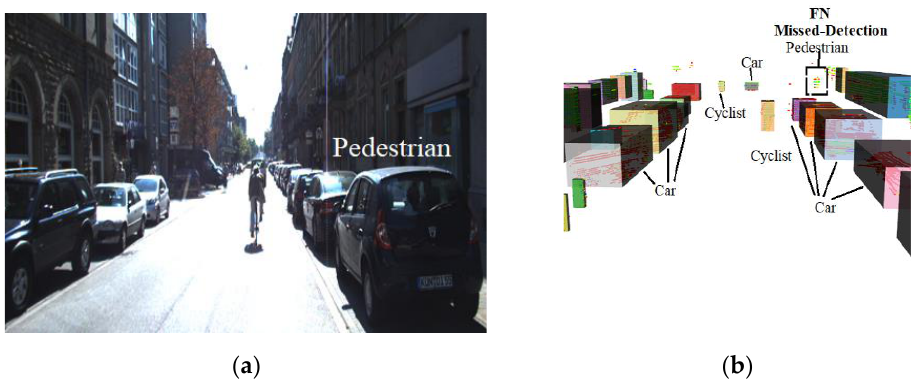
Figure 21. Missed detection in KITTI dataset experiments: ( a ) scene image; ( b ) proposed method.